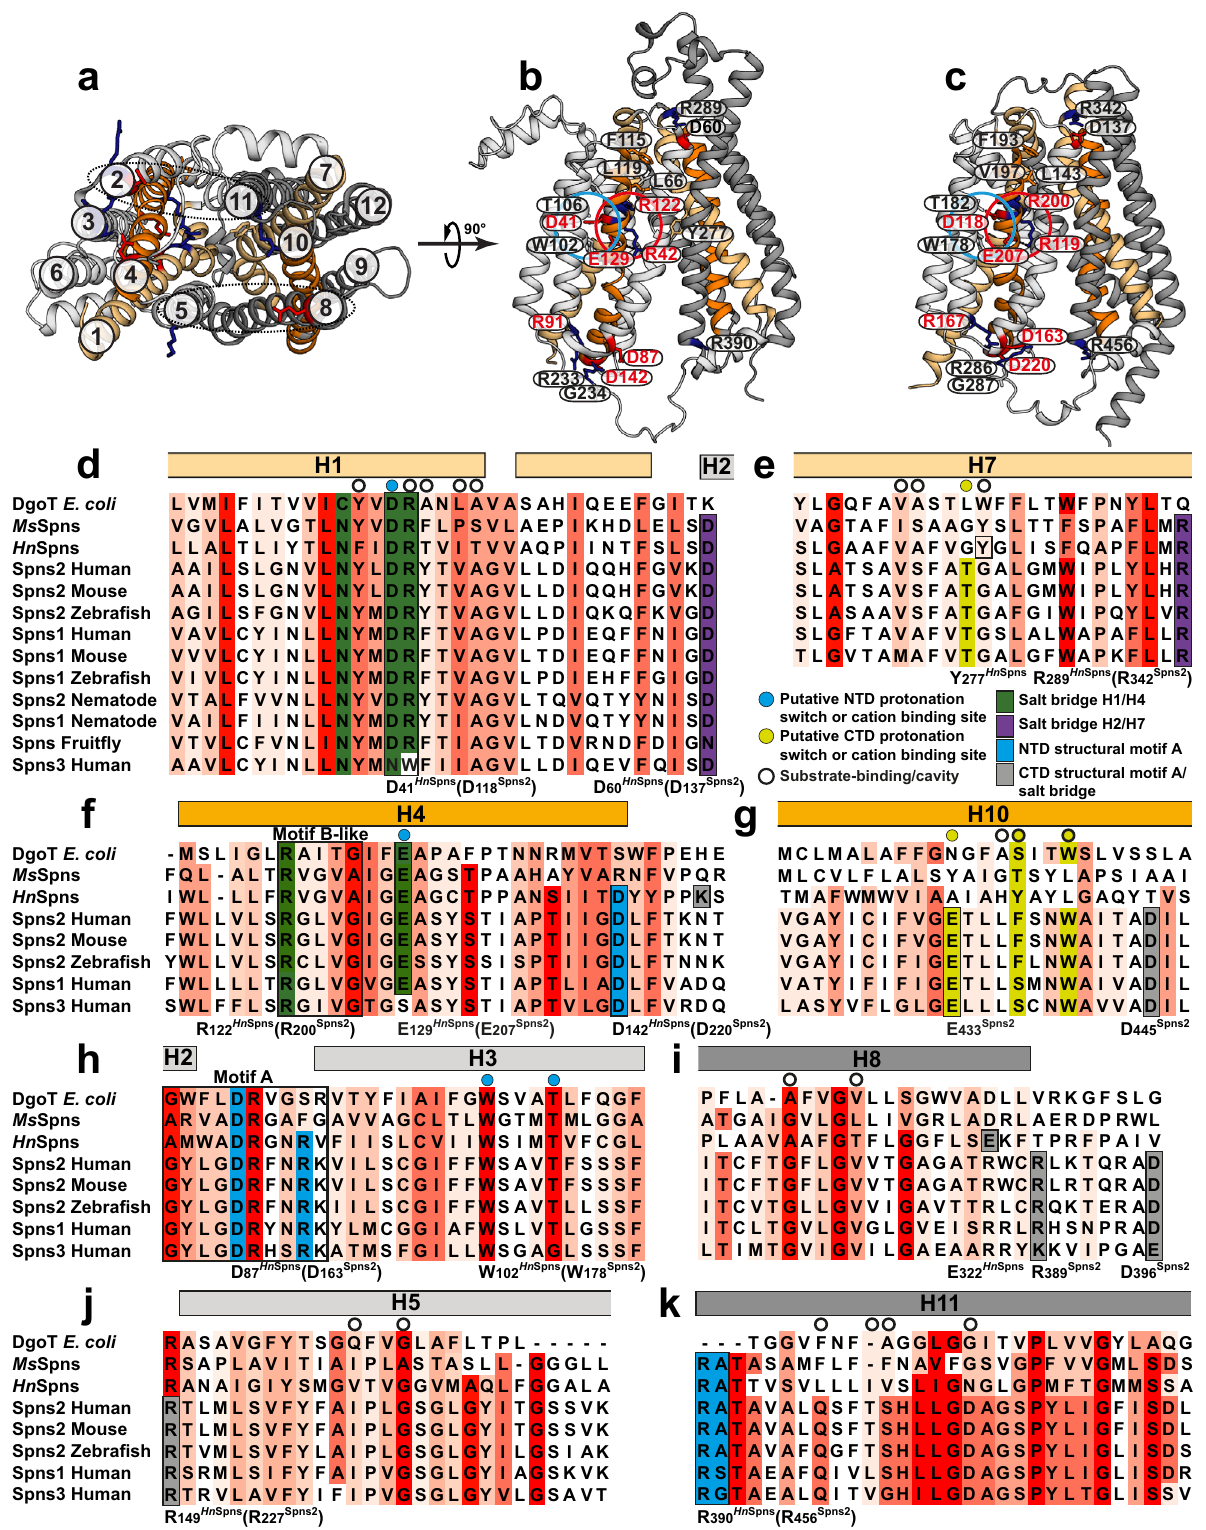
Fig. 1 | The architecture and sequence alignment of Spns proteins. a Cytoplasmic view of the Hn Spns crystal structure (Protein Data Bank (PDB) code 6E9C) in the IF state with the NTD and CTD colored in light and dark gray, respectively. b Membrane view of Hn Spns with the positions of conserved and functional residues labeled. Symmetry-related TM helices 1/7 and 4/10 are colored with light and dark orange, respectively. c AlphaFold model of human Spns2.